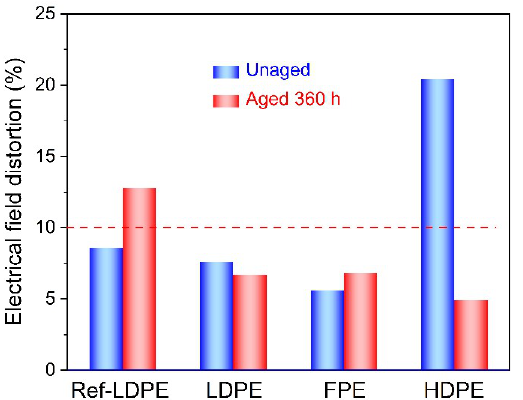
Figure 15. Electric field distortion of single-layer samples polarized for 30 min under − 50